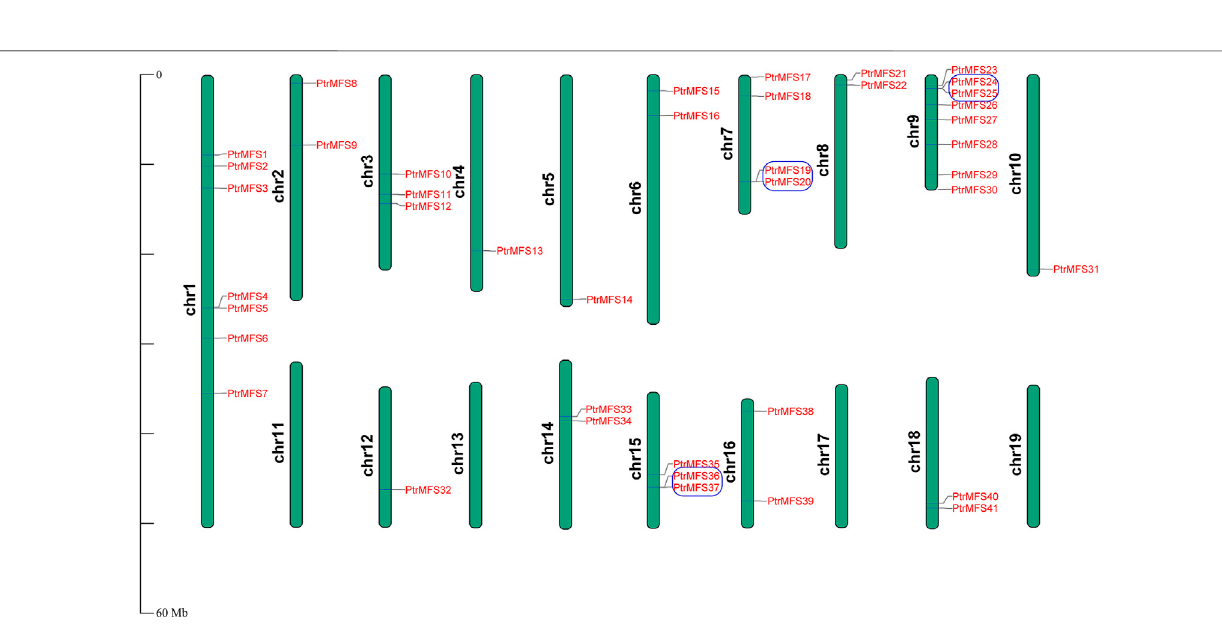
Frontiers in Genetics |